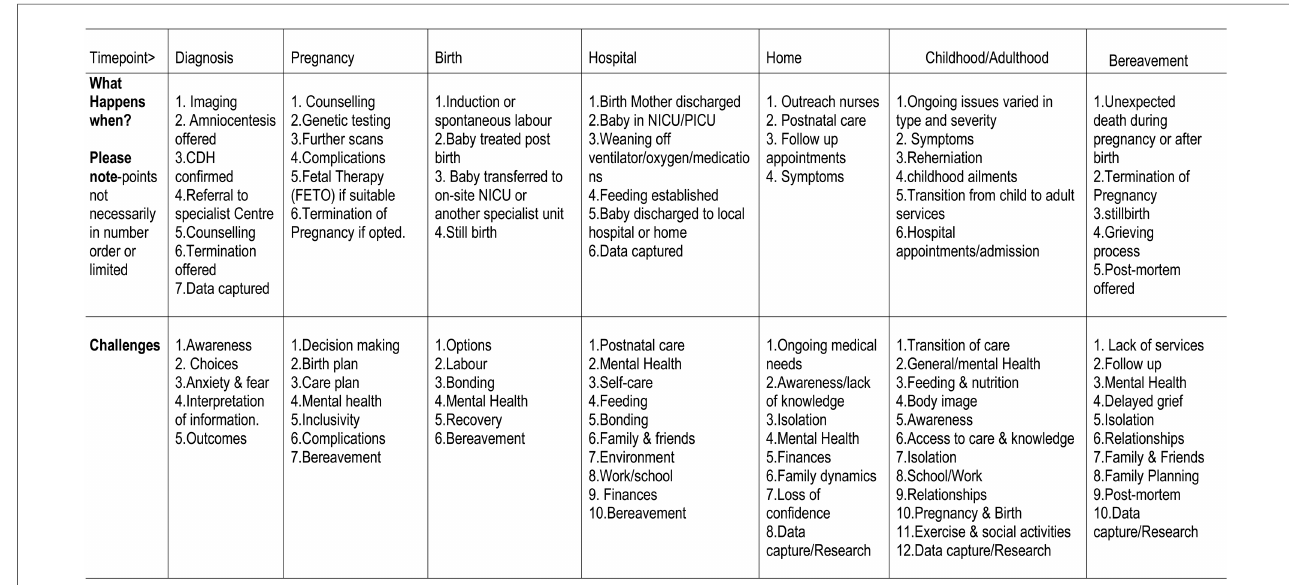
FIGURE 4 Table of amendments.